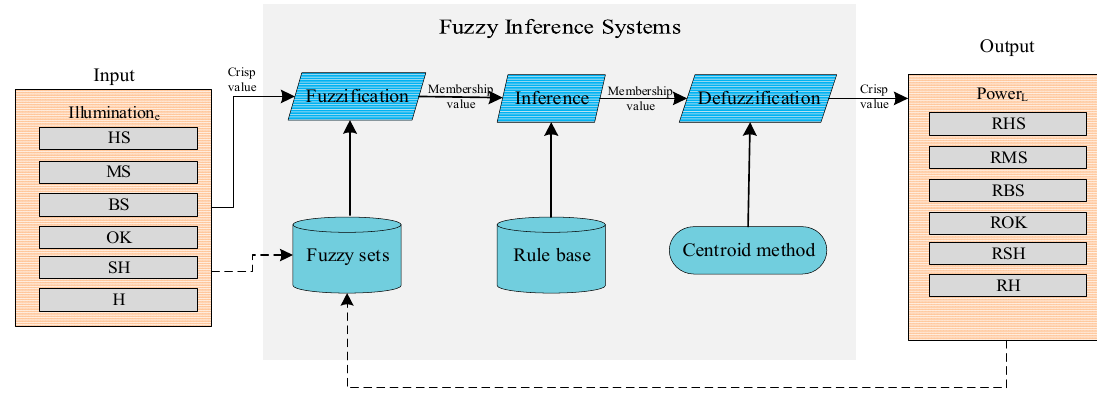
Figure 11. Structure diagram for illumination fuzzy controller.